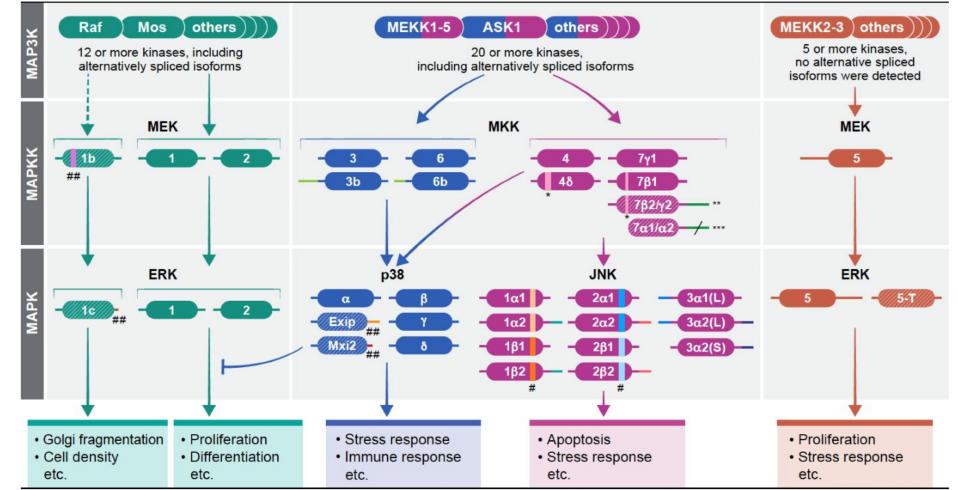
Figure 1. Signaling specificity and multiple isoforms of the MAPK signaling pathways. The MAPKs operate within signaling cascades composed of three to five layers (tiers) of protein kinases. The signals from the cascades are trans- mitted via sequential phosphorylation and activation of the components in each layer. The four cascades, which have been identified are shown: the human ERK1/2 cascade with MEK1/2/1b and ERK1/1c/2 at the MAPKK and MAPK layers. The p38MAPK cascade with MKK3/3b/6/6b, and p38 α /Exip/Mxi2/p38 β /p38 γ /p38 δ ; the JNK cascade with MKK4/4 δ /7 γ 1/ γ 2/ β 1/ β 2/ α 1/ α 2 and JNK1 α 1/1 α 2/1 β 1/1 β 2/2 α 1/2 α 2/2 β 1/2 β 2/3 α 1(L)/3 α 2(L)/3 α 2(S); and the ERK5 cascade with MEK5, and ERK5/5-T. It should be noted that the isoforms presented are those whose expression has been confirmed. Other alternatively spliced transcripts whose protein expression is not confirmed or may exist in other organisms are not presented here as well. The main proteins in each layer of each cascade (except for JNK) appear on top. As for JNK, it seems that all components may be substantially expressed, at least in some cells. Each of the kinases is composed of a kinase domain (central region) as well as N and C terminus represented by a line on the left ( N terminus) and right ( C terminus) of all kinase domains. The patterns in some of the proteins (e.g., MEK1b) represent low expression levels (less than 10% of the main gene product). Different colors and length in the N or C terminus represent distinct sequences and number of AA compared to the main isoform (e.g., ERK1c). In order to make changes more visible, the scale is not always accurate. * insertion, ** β 2 without insertion, γ 2 with insertion, *** α 1/ α 2 have different length C termini, # alternative exon 6 between the α and β isoforms that result in a change of 5–7 amino acids in this region. ## deletion. More information on the structure appears in Table